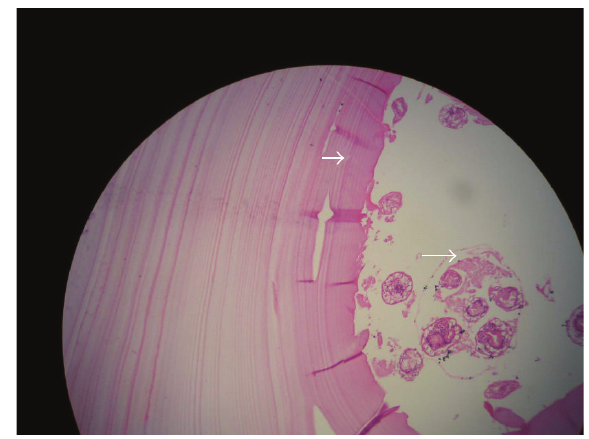
Figure 2: Microphotograph of the lesion reveals laminated mem- brane (large arrow) and the scolices (small